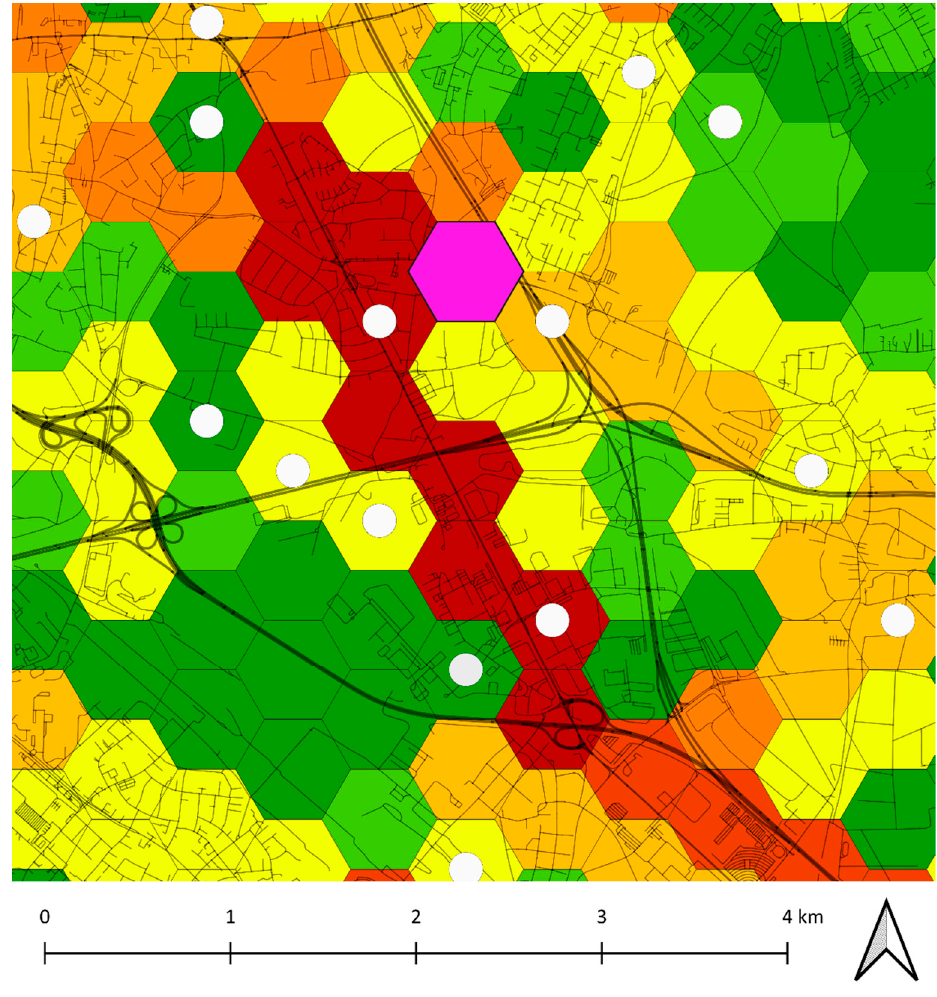
Figure 7. Part of the criticality analysis of Colognes district Kalk.